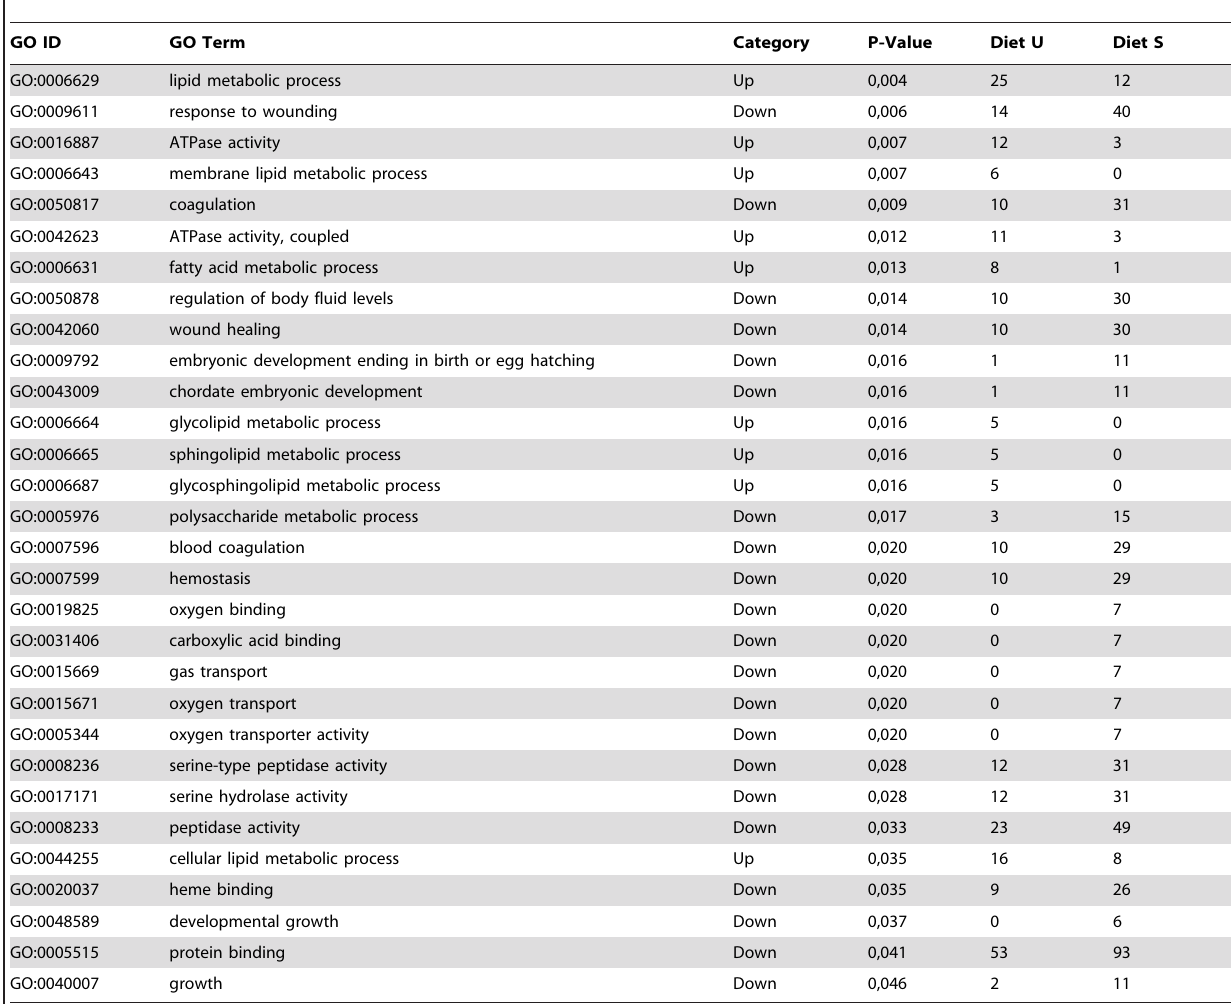
Table 4. Differential Gene Ontology terms between contigs derived from Diet U and Diet S SSH cDNA